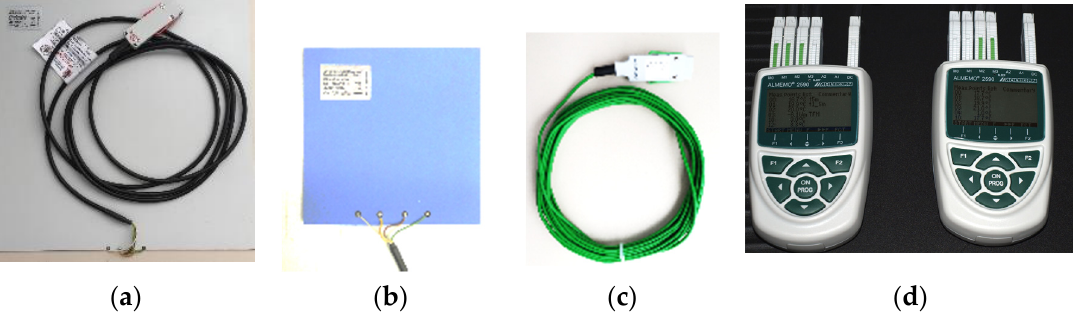
Figure 1. ( a ) Placement of the thermal flow plate and probes on the exterior face of the facade; ( b ) Thermographic image of the facade.